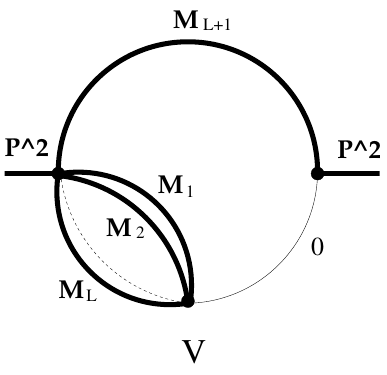
Figure 3 . L -loop V-type